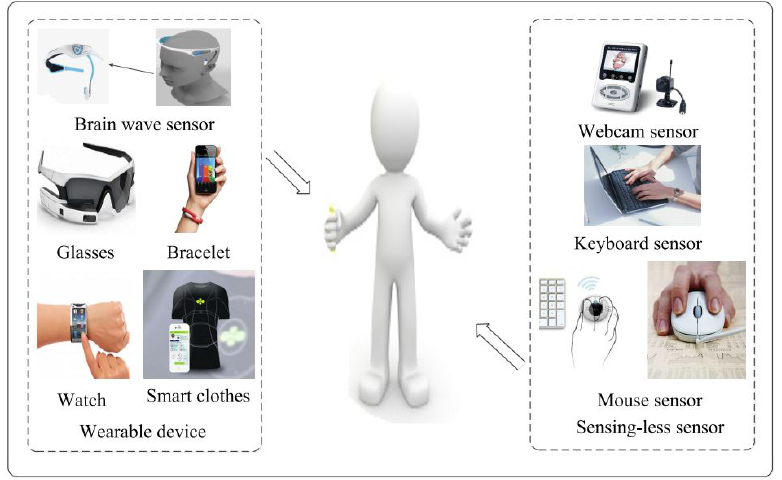
Figure 3. Various medical devices using sensors